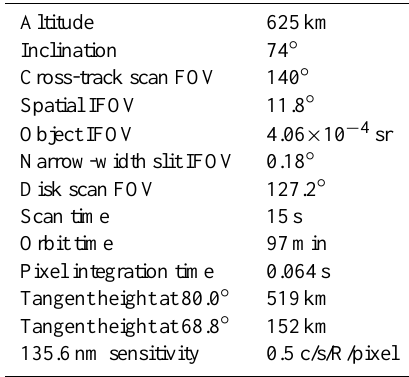
Table 1. Summary of GUVI instrument